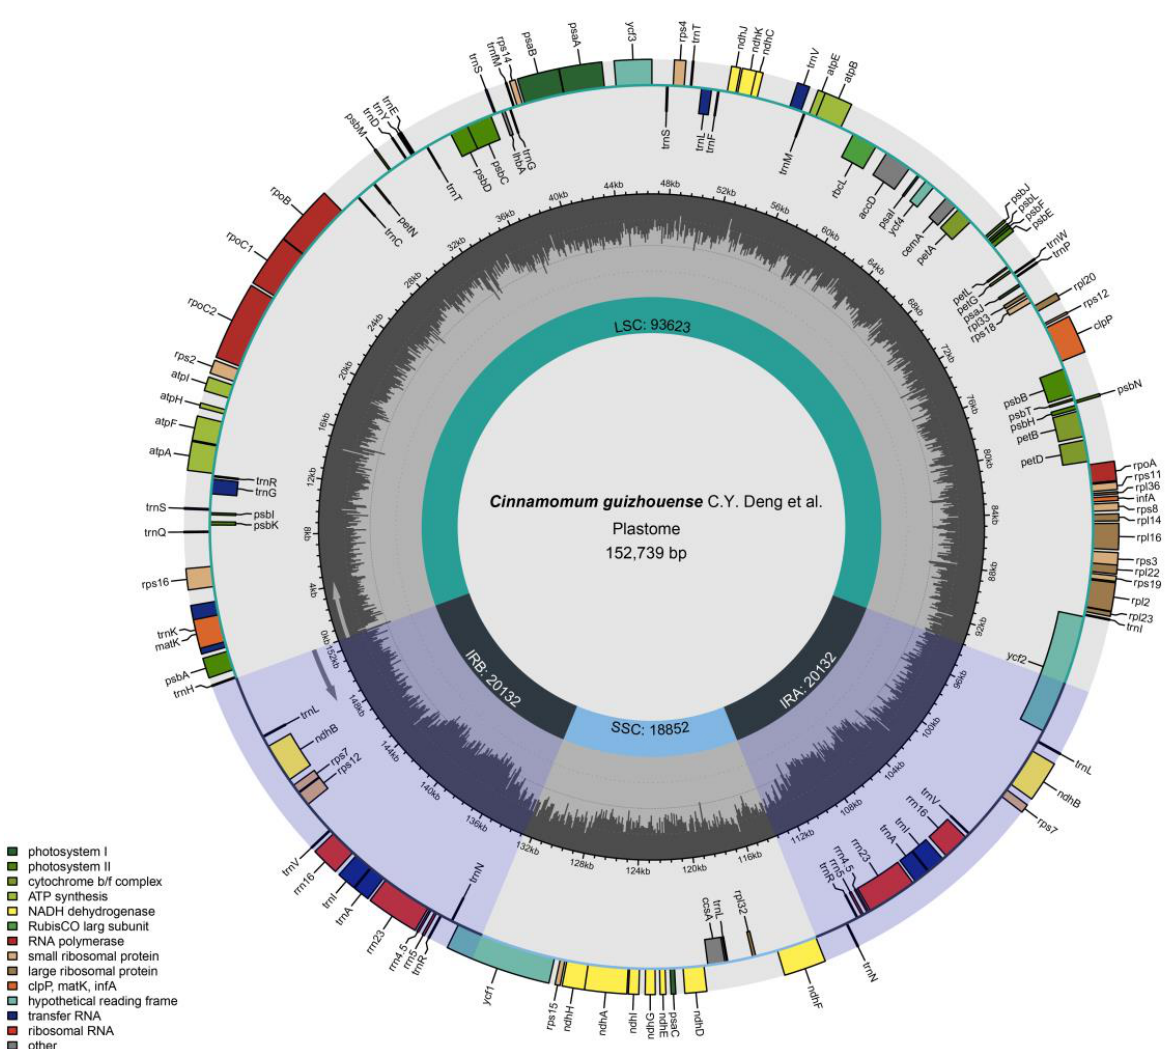
Figure 1. Gene map of Cinnamomum guizhouense C.Y. Deng et